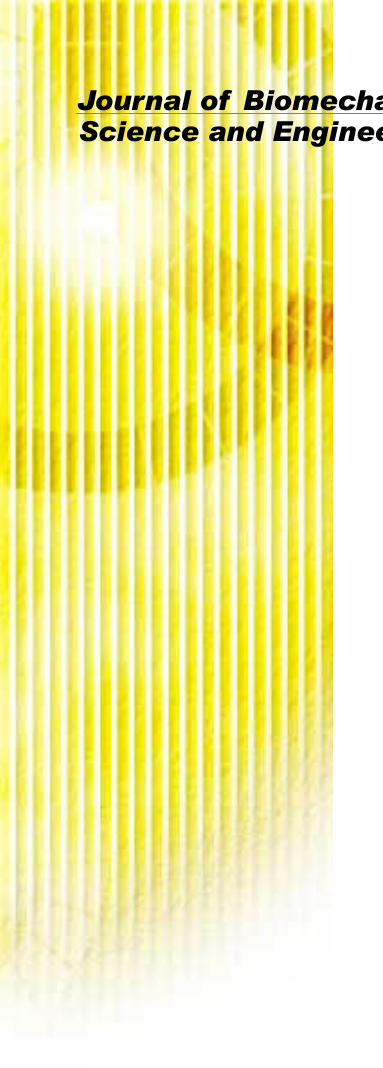
Fig. 7 Effect of initial growth factor distribution on network morphology. Each model on day 5 was dyed with CellTracker, and then imaged at 5- µ m intervals in depth using confocal laser scanning microscopy. Typical network of gel-bFGF model (A) and medium-bFGF model (B). Networks in the gel-bFGF model extended deep into the collagen gel (A), whereas that of the medium-bFGF model extended only slightly beneath the collagen surface (B). (C) Network length measured from the CellTracker fluorescent image recorded at 5- µ m intervals in depth, and